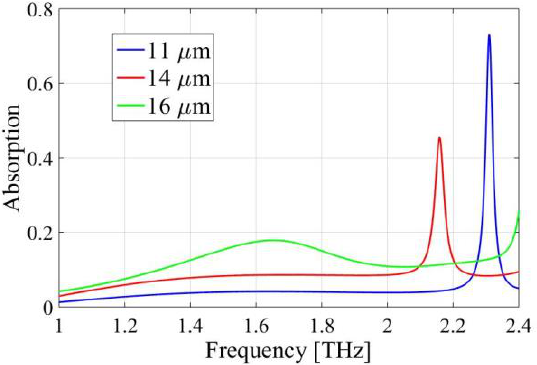
Figure 7. Absorption responses of CrossPMA for three different H9N2 thicknesses above 10 µm. The detection is not only limited by the upper bound d min